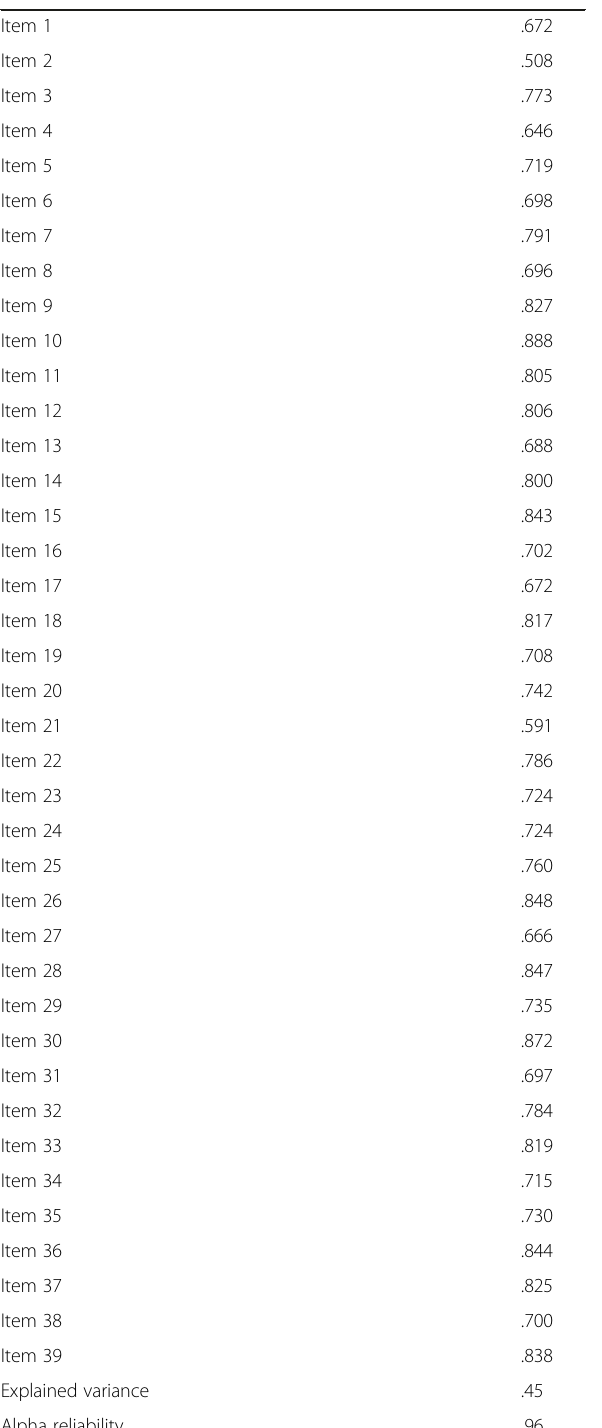
Table 1 Factor loadings of the PAB-S − 39